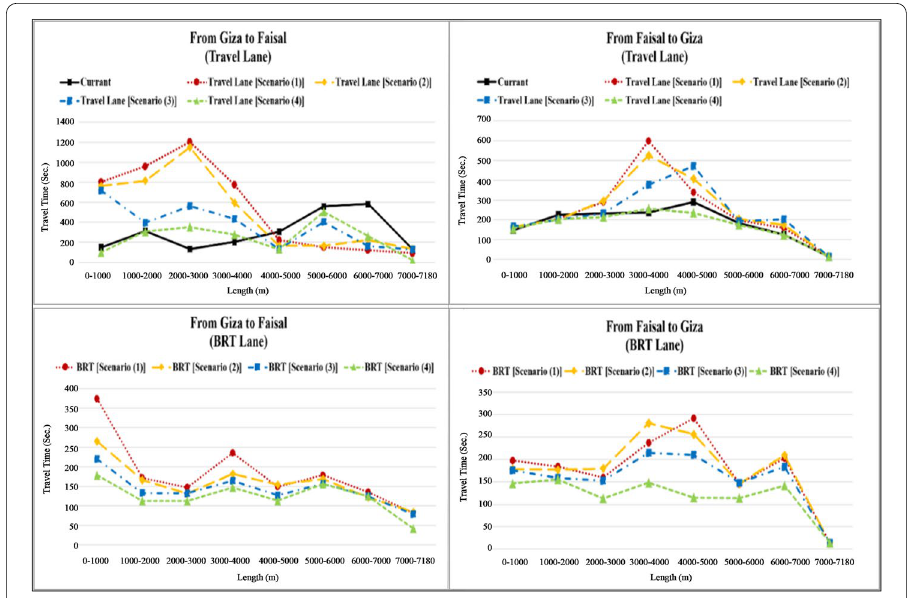
Fig. 6 Segment average travel time (travel lane and BRT